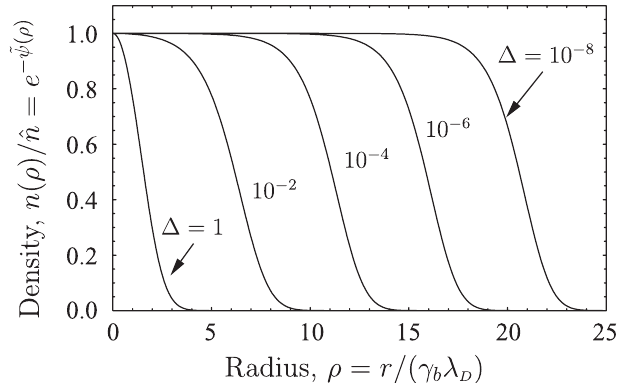
FIG. 17. For a thermal equilibrium, the scaled density n ð (cid:12) Þ = ^ n ¼ exp ð(cid:1) ~ c Þ is plotted versus the scaled radial coordinate Þ calculated from the solution of the scaled thermal (cid:4) (cid:12) ¼ r= ð (cid:8) b D equilibrium Poisson equation (F5) for (cid:1) ¼ 10 (cid:1) ‘ with ‘ ¼ 0 , 2, 4, 6, and,